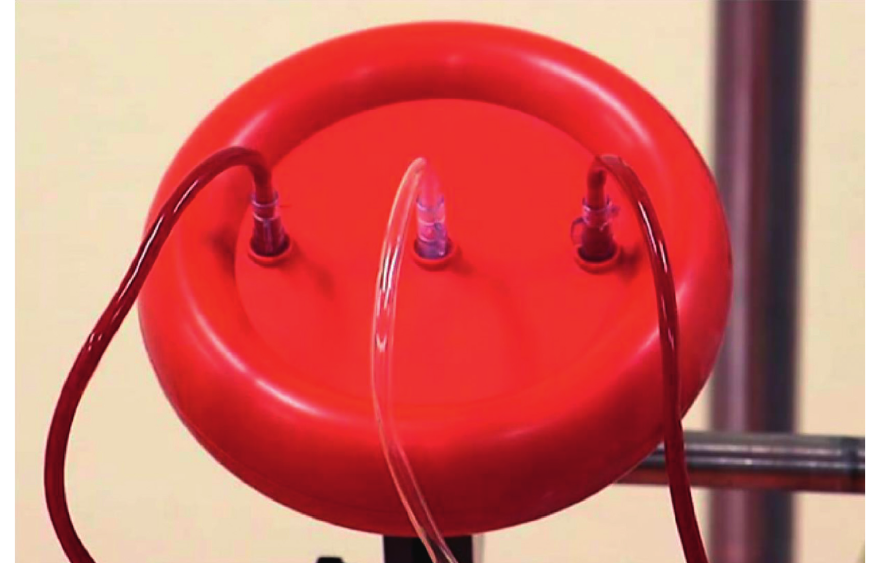
Figure 1: The HemoClear device at work. Shed blood enters the filter from the left inlet and is separated into concentrated RBCs that leave the filter from the right outlet and plasma that flows away in the middle